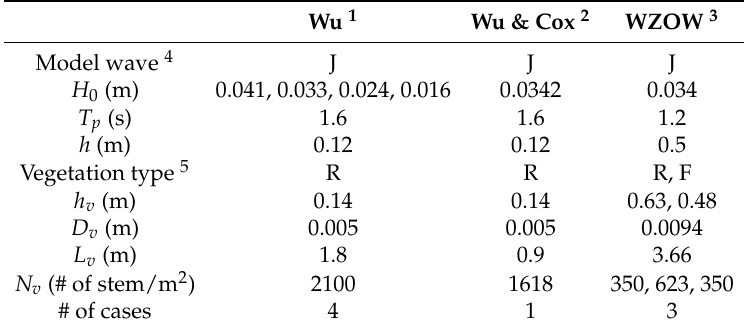
Table 2. Experimental conditions of the laboratory tests used to examine the effectiveness of the drag coefficient Formula